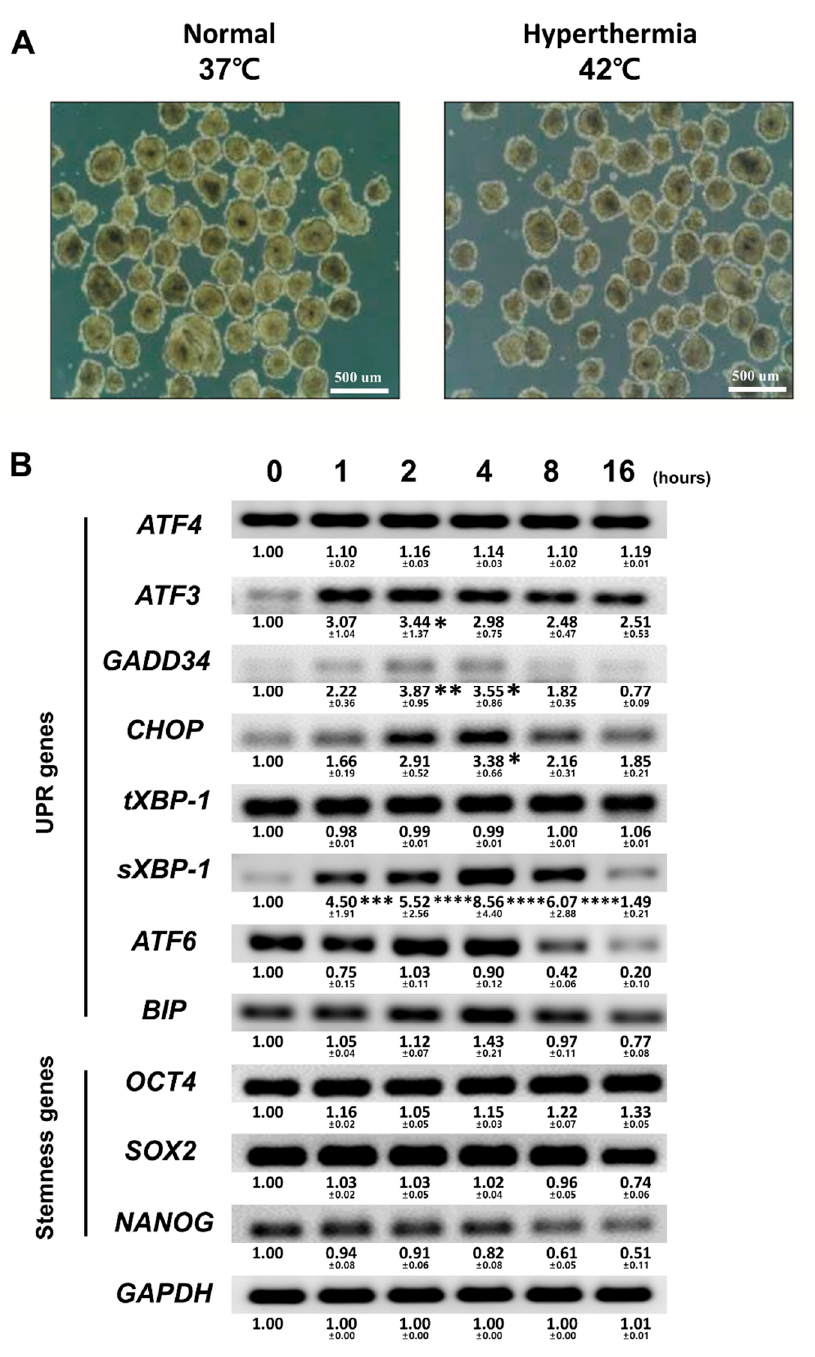
Figure 1. Determination of the optimal experimental hyperthermic conditions for unfolded protein response (UPR) activation without causing human embryonic stem cell (hESC) death. ( A ) Phase-contrast images showing in vitro spontaneous differentiation of the hESCs under normal and hyperthermic conditions. ( B ) Gene expression analysis by RT-qPCR using total RNA isolated from spontaneously differentiated EBs exposed to a hyperthermic condition for the indicated times. The embryoid bodies (EBs) expressed UPR genes and stemness genes. Fold changes of signal intensity were normalized by GAPDH intensities. Fold changes represent the mean values obtained from the three independent experiments. Statistical significance was determined by comparing the relative band intensities referring to those of undifferentiated hESCs as 1. Student’s t-test: * p < 0.05, ** p < 0.01, and *** p < 0.001, **** p < 0.0001.